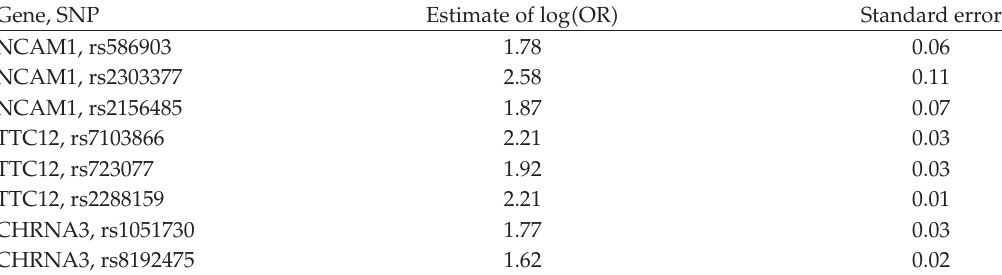
Table 4: Risk parameter estimates and standard errors in the alcohol dependence data. Gene, SNP Estimate of log (cid:3) OR (cid:4) Standard error NCAM1,